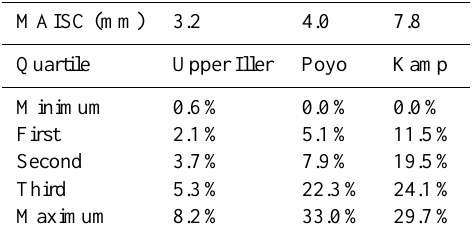
Table 7. Peak discharge reduction quartiles for the afforestation sce- narios (more optimistic giving different MAISC at each catchment).